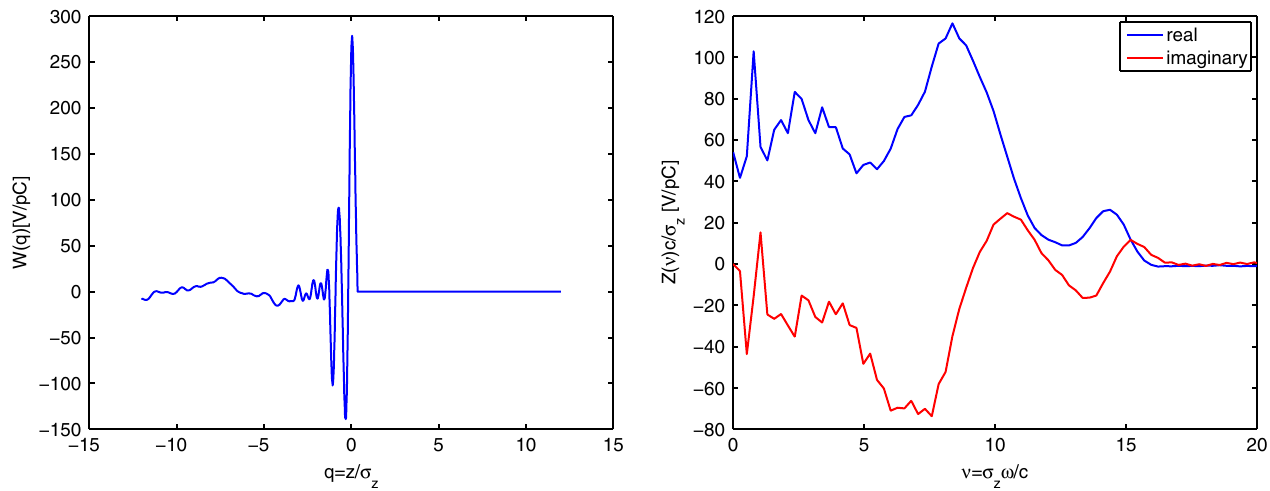
¼ 4 : 946 mm (bunch length at zero z